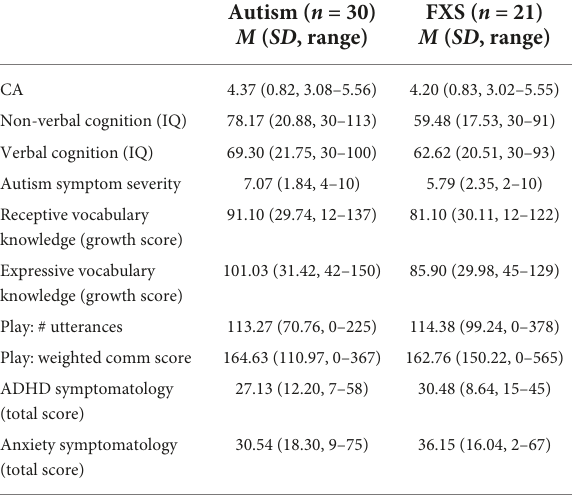
TABLE 1 Descriptive statistics for participant